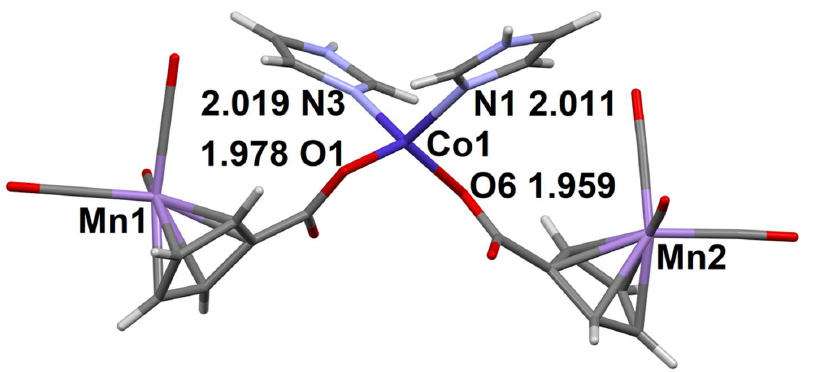
Figure 1. Asymmetric unit in the structure of compound 1 . The distances between the coordinating oxygen atoms of aqua ligands and the Co 2+ ion are given (Å).